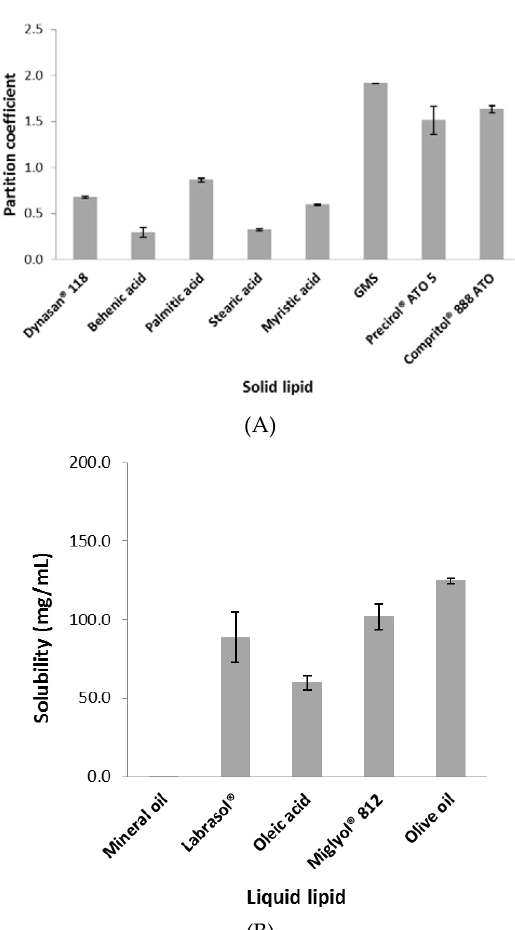
Figure 2. ( A ) The partition coefficient of PR in solid lipids ( n = 3, mean ± standard deviation (SD)); ( B ) the solubility of PR in liquid lipids ( n = 3, mean ± SD).